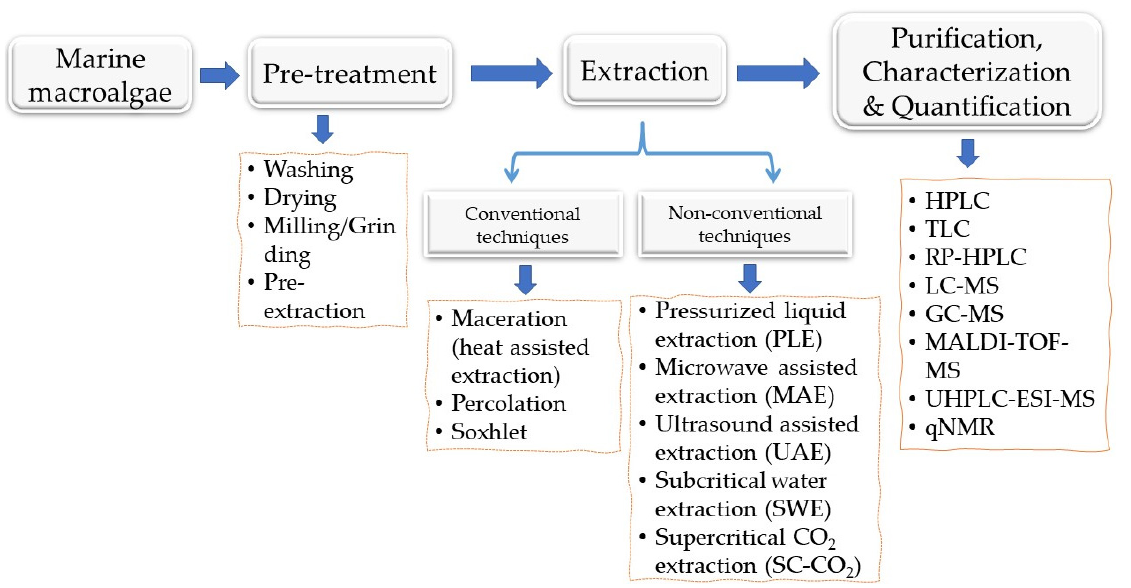
Figure 5. Techniques of extraction and characterization for phenolic compounds. Source: Santana- Gálvez and Jacobo-Velázquez [232].